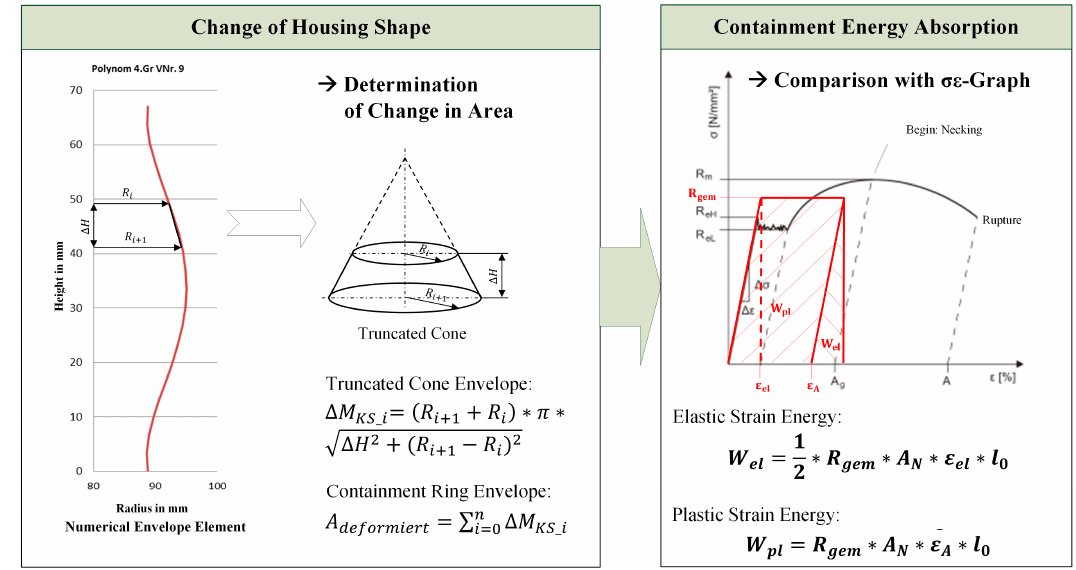
Figure 16. Step 3b—Determination of plastic deformation work of the burst containment.